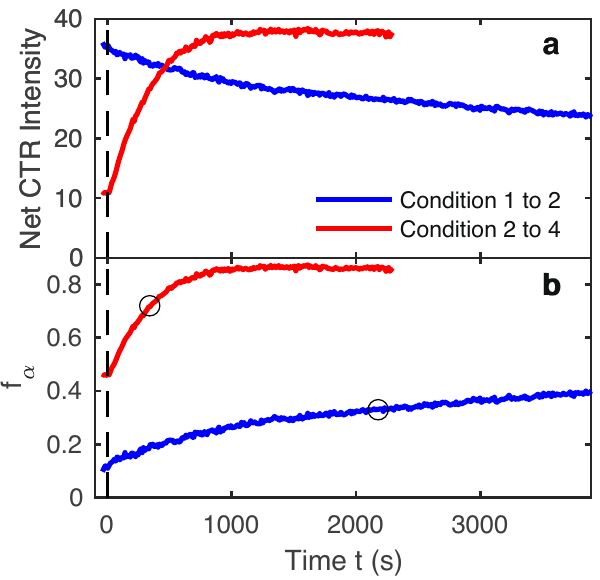
Fig. 6 Dynamics following a change of condition at t = 0. a Measured CTR intensities. b Calculated terrace fractions f α . Blue curves: conditions 1 – 2 on the ð 1012 Þ CTR at L = 1.627. Red curves: conditions 2 – 4 on the ð 0112 Þ CTR at L = 1.603. Circles show 1/ e relaxation times t rel of 2200 ± 200 and 340 ± 30 s, respectively.